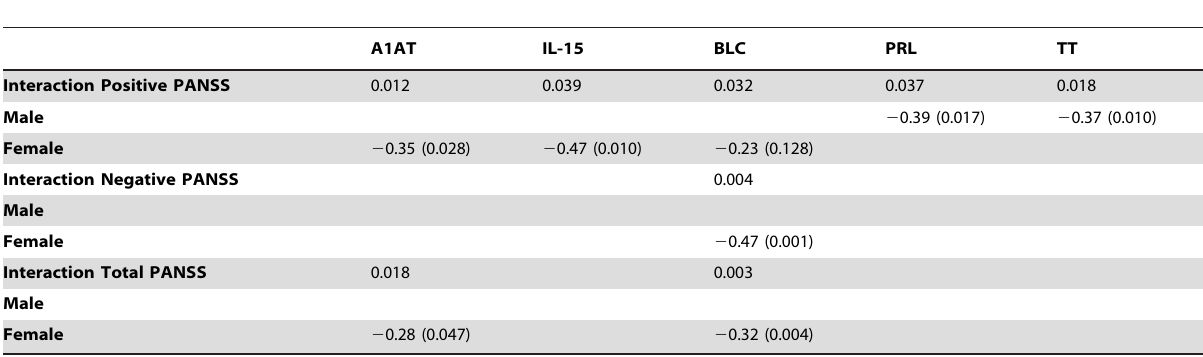
Table 5. Summary of sex-specific associations with positive, negative, and total PANSS score